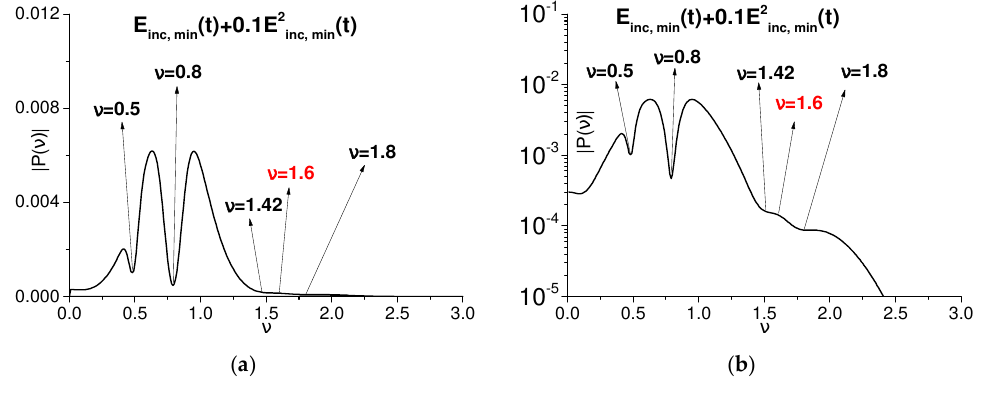
Figure 8. Fourier spectrum of the signal E